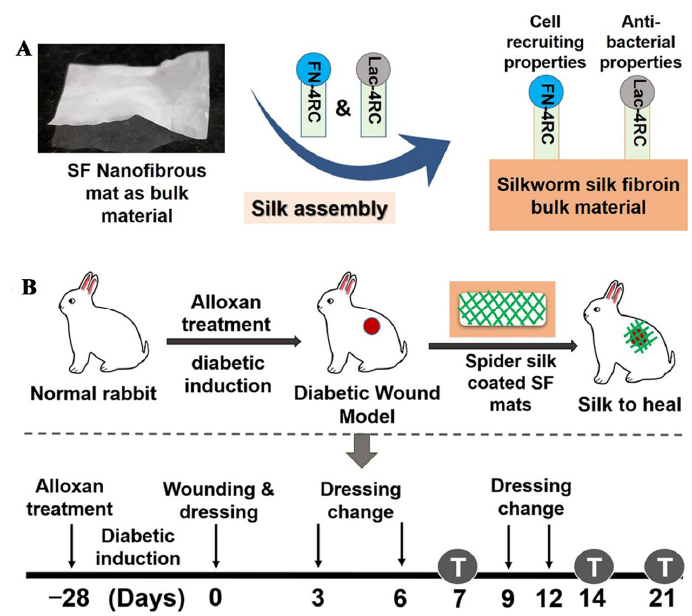
Figure 3. Schematic diagram of the experiment. ( A ) preparation of the nanofiber membrane, ( B ) procedure of wound treatment in diabetic rabbits. Reproduced with permission from [71], ACS, 2019.